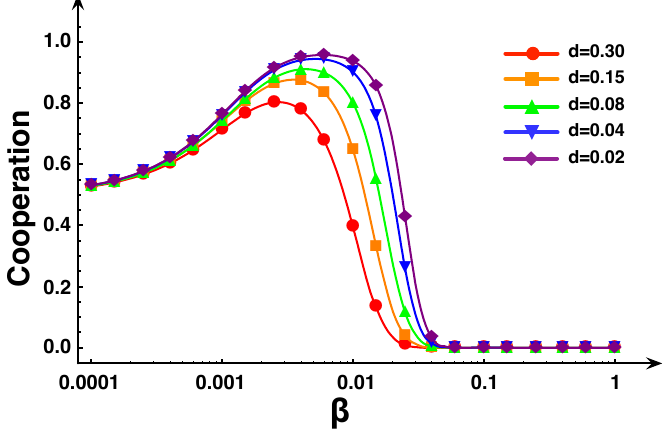
Figure 8. Role of separation d between consecutive rates in the evolutionary success of cooperators. The plots shows the fraction of time the population spends in a cooperative state (of any type) for a given intensity of selection. Symbols represent the data. The lines are the result of a spline interpolation of the data. Each data set corresponds to a different distance d between consecutive rates (and types) in the population. Smaller values of d lead to more cooperation, an effect that becomes more pronounced for intermediate intensities of selection. In these regimes, small distances between types can effectively reduce the “flow” towards the slowest defector type, as discussed in Section 3. ( N = 100 , T = 2 . 1 , R = 2 , P = 1 , S = 0 . 9 , c = 0 . 16 , δ = 0 . 3